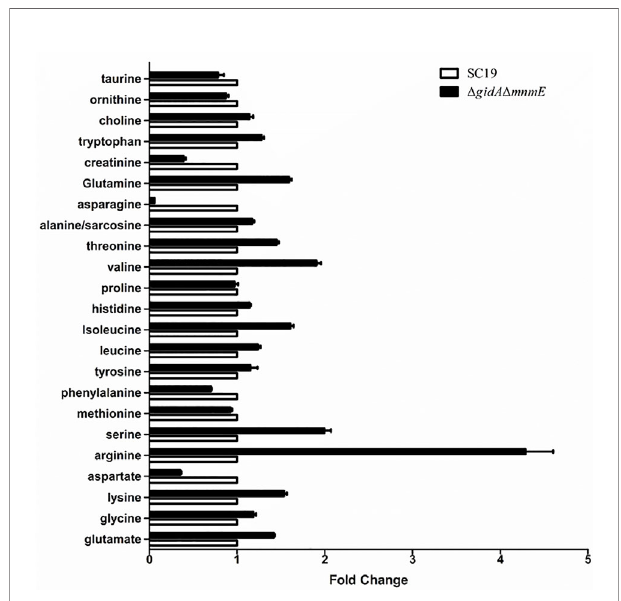
FIGURE 5 | Identi fi ed 23 amino acids metabolites between SC19 and D gidA D mnmE .